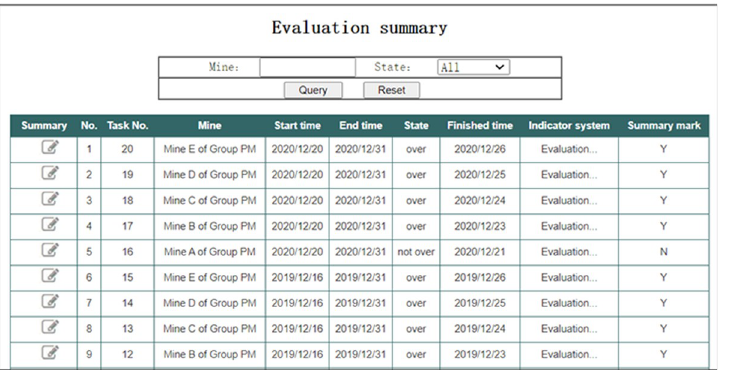
Fig 17. Evaluation summary.